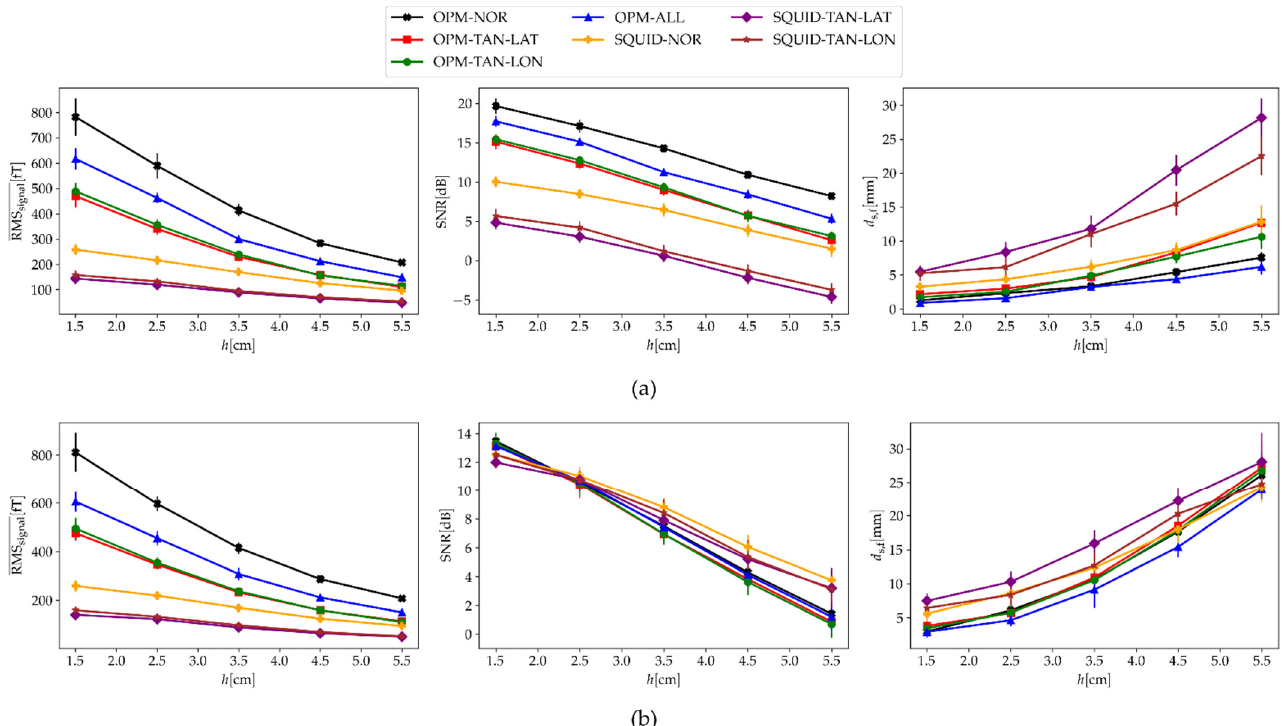
Figure 9. Calculated values of RMS signal , SNR, and d s,f in relation to the depth of the simulated dipoles ( h ). The strength of the ambient noise and the spontaneous brain noise was ( a ) σ = 75 fT and q spont = 0, and ( b ) σ = 0 and q spont = 3 nAm. Note that the value of h on the x-axis means, that the dipoles were chosen at a depth of h ± dh ; in our case, dh = 0.5